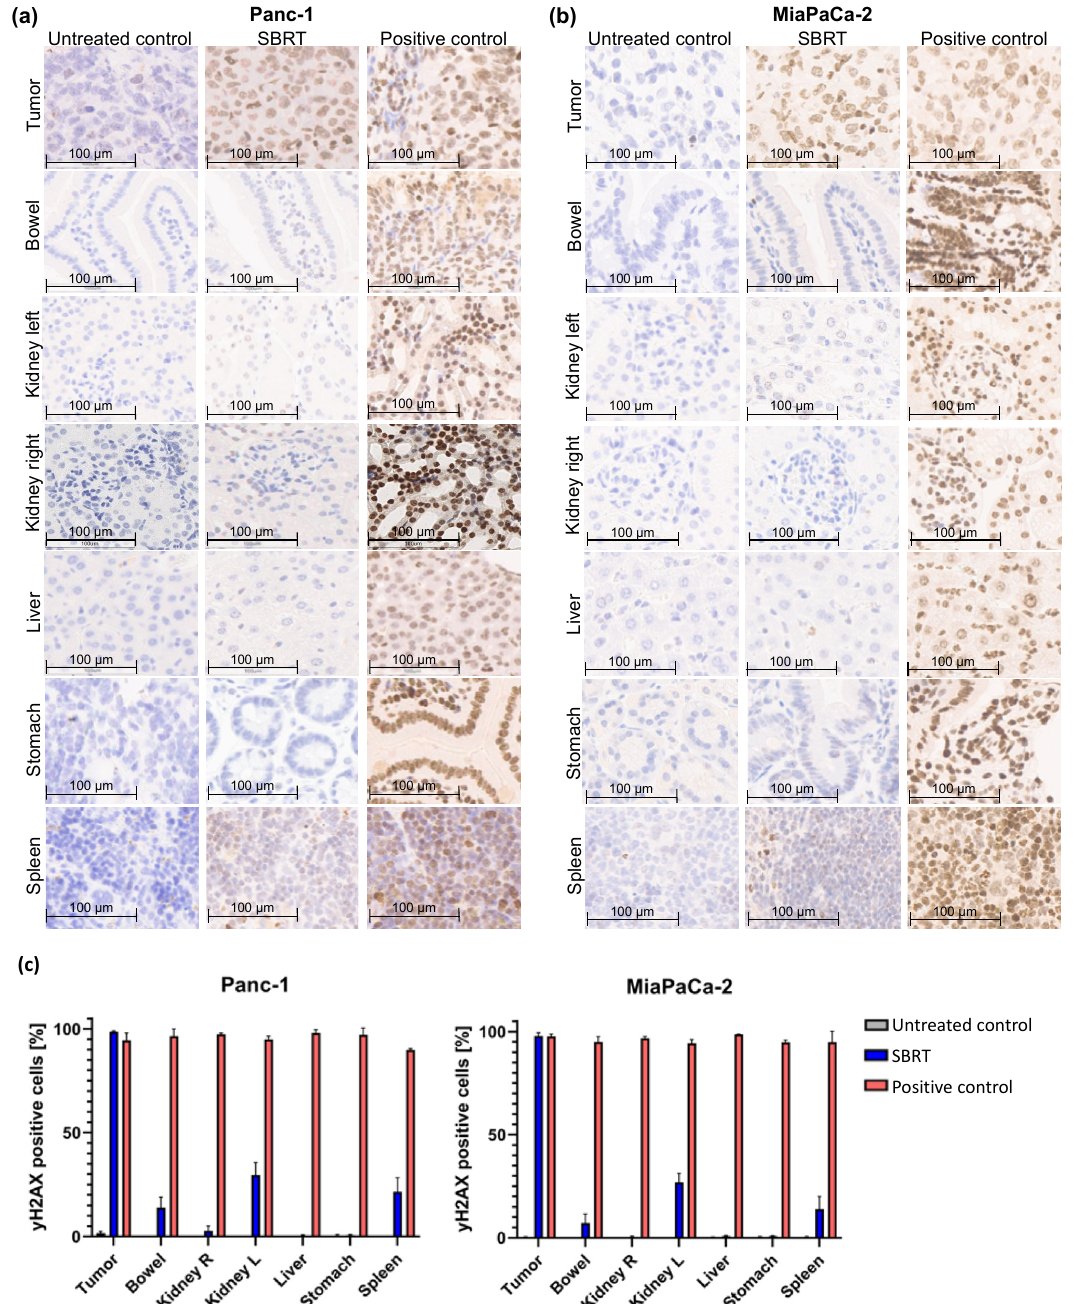
Figure 2. γ H2AX staining by IHC and percentage of γ H2AX-positive cells of different orthotopic pancreatic tumor tissues and OARs without RT (untreated control), one hour after SBRT, and whole-abdomen RT (positive control). ( a ) Representative orthotopic Panc-1 tumor tissue and OARs; ( b ) Representative orthotopic MiaPaCa-2 tumor tissue and OARs; ( c ) Quantification of the distribution of γ H2AX-positive cells in the tumor tissue and OARs of all included mice. The γ H2AX staining was validated by counting the total and γ H2AX-positive cells of tumor tissues and OARs of all included mice. Almost 100% of γ H2AX-positive cells are shown in pancreatic tumors after SBRT, comparable to the positive control. A mean value of 10%, 28%, and 16% γ H2AX-positive cells was observed in the bowel, left kidney, and spleen after SBRT, respectively. The liver, stomach, and right kidney showed almost no γ H2AX-positive cells after SBRT compared to the unirradiated